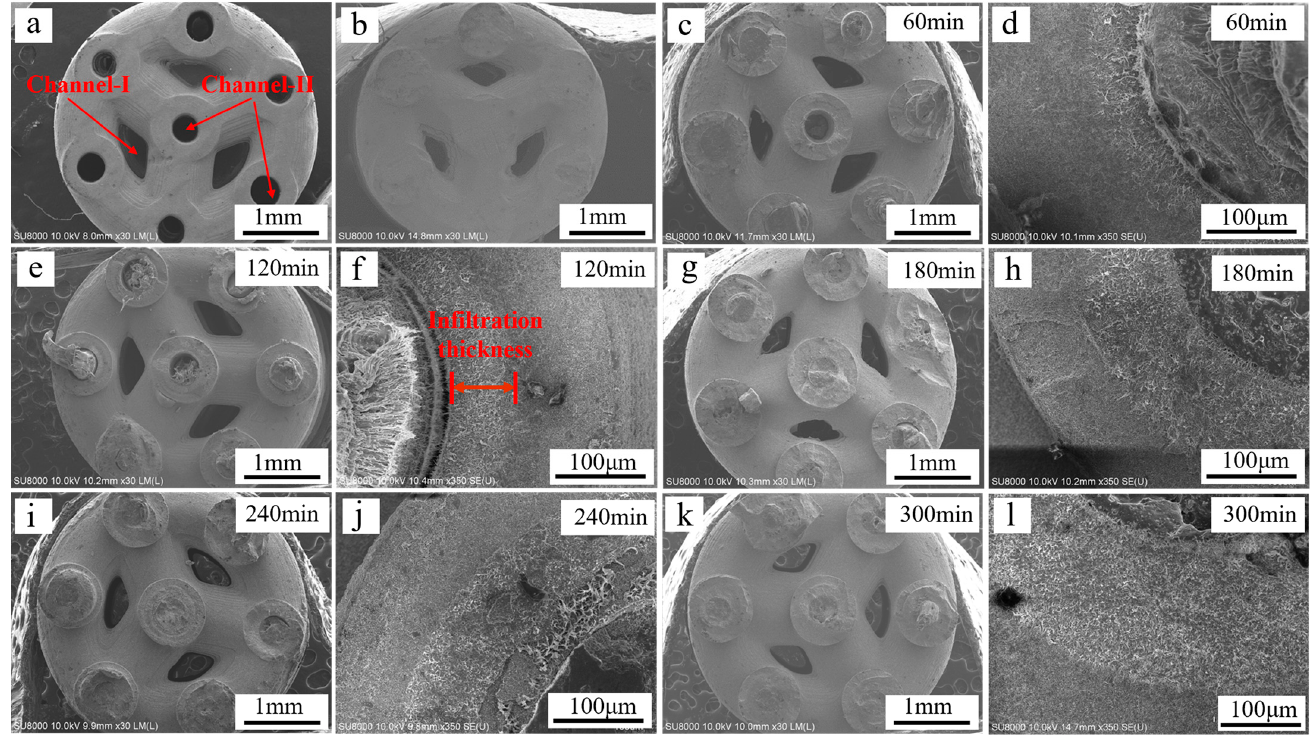
Figure 3. SEM micrograph of scaffolds cross-sections for ( a ) hollow scaffolds ( b ) dense scaffolds and composite scaffolds infiltrated with the PCL matrix composite for different infiltration times: ( c , d ) 60 min, ( e , f ) 120 min, ( g , h ) 180 min, ( i , j ) 240 min, ( k , l ) 300